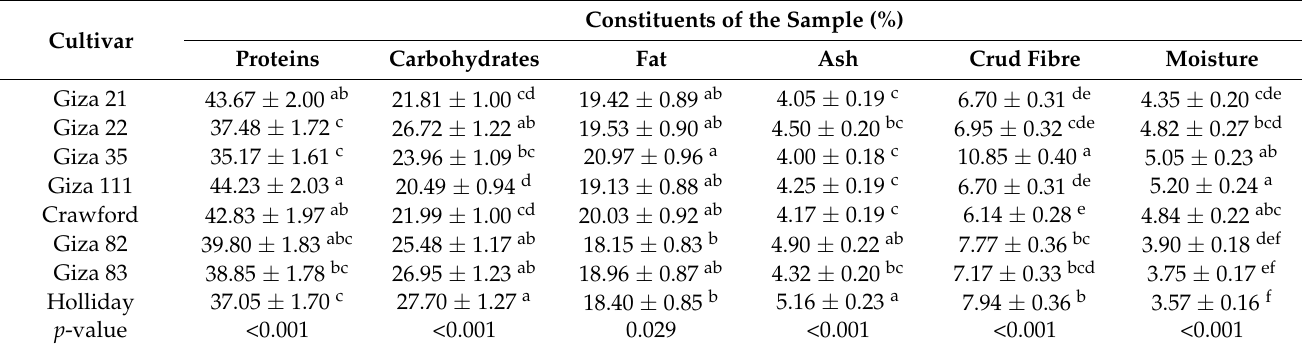
Table 1. Chemical composition of the eight soybean cultivars. Constituents of the Sample Cultivar